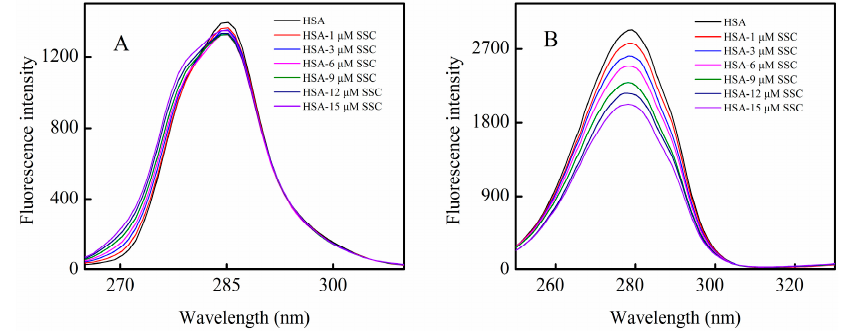
Figure 4. Synchronous fluorescence spectra of the SSC-HSA system. The experimental conditions were as described in Figure 2. A, Δλ = 15 nm for tyrosine; B, Δλ = 60 nm for tryptophan. C HSA = 2 μ M.